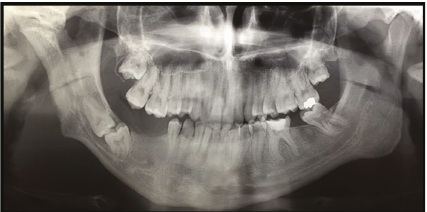
Figure 3: Preoperative panoramic radiography showing altered condylar morphology on the right side, mandibular asymmetry, and impaction of the teeth 47 and